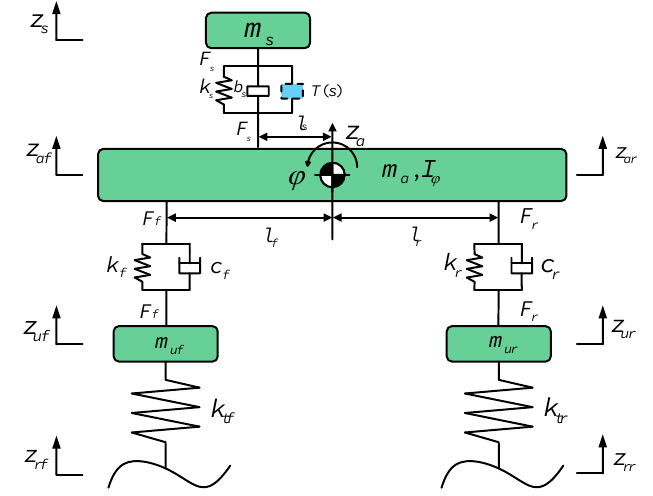
Figure 1. Seven-degree-of-freedom vehicle